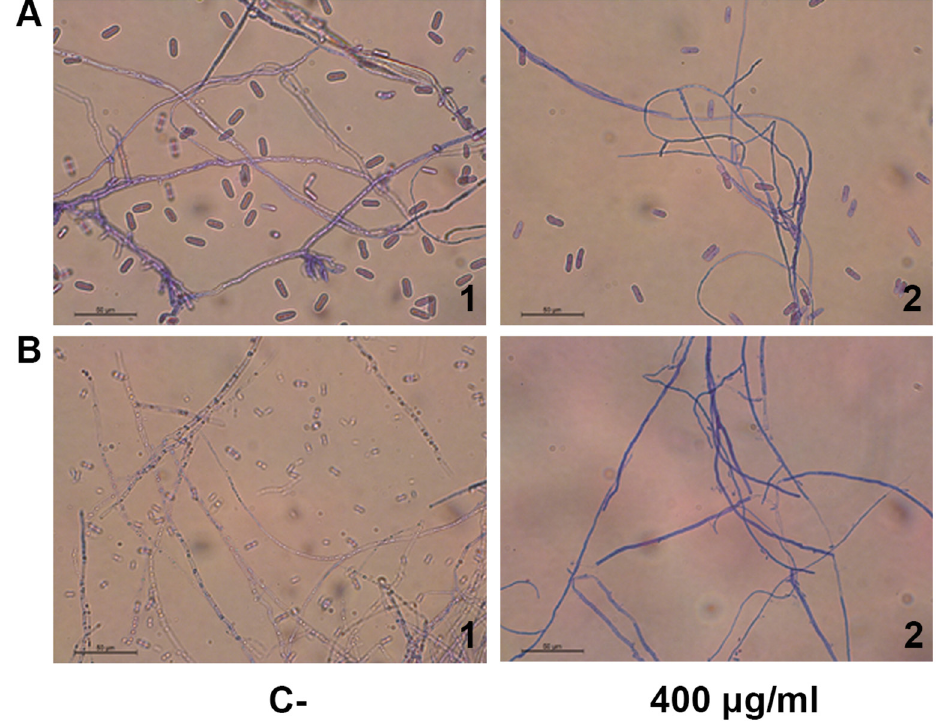
Figure 3. PaSn plasma membrane permeabilization. Optical micrographs 40X displaying staining mycelia with trypan blue 5%. ( A ) Colletotrichum gloeosporioides (1–2), and ( B ) Fusarium oxysporum (1–2) mycelial growth inhibition. 1: MBP negative control, 2: PaSn (400 μ g/mL).